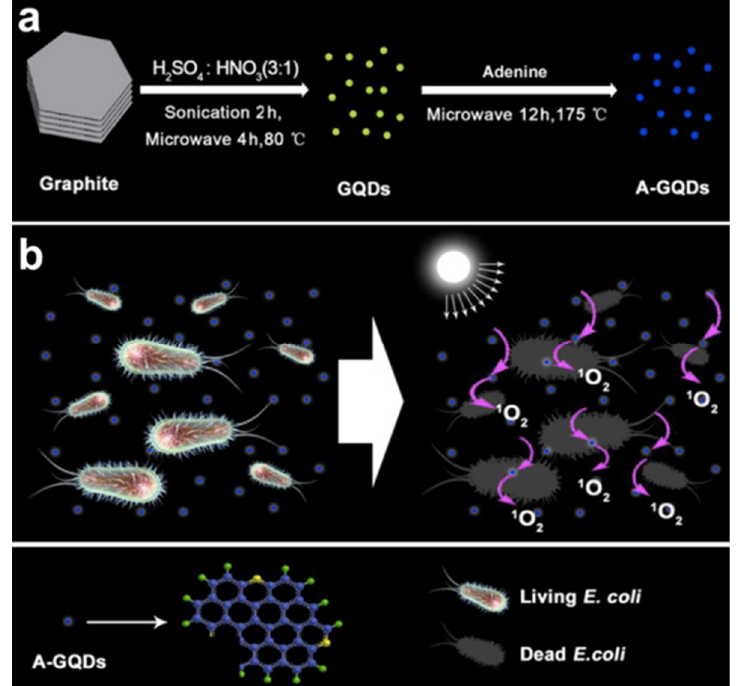
Figure 7. ( a ) Schematic illustration depicting the microwave‐assisted preparation of A‐GQDs. ( b ) White light‐activated antibacterial property of A‐GQDs towards E. coli. GQDs aqueous solution and adenine were reacted in a quartz tube for 12 h in the microwave reactor at 175 °C and left for 12 h at 4 °C, subsequently filtered by a microporous membrane to remove the residual adenine. Two‐day dialysis was performed to obtain a pure colloidal solution. After evaporation, A‐GQDs were obtained for the further use. For the first time, it was shown that the adenine modified GQDs also own white light‐activated antibacterial features along with their high fluorescence ability with a QY of 21.63% at 350 nm [61].